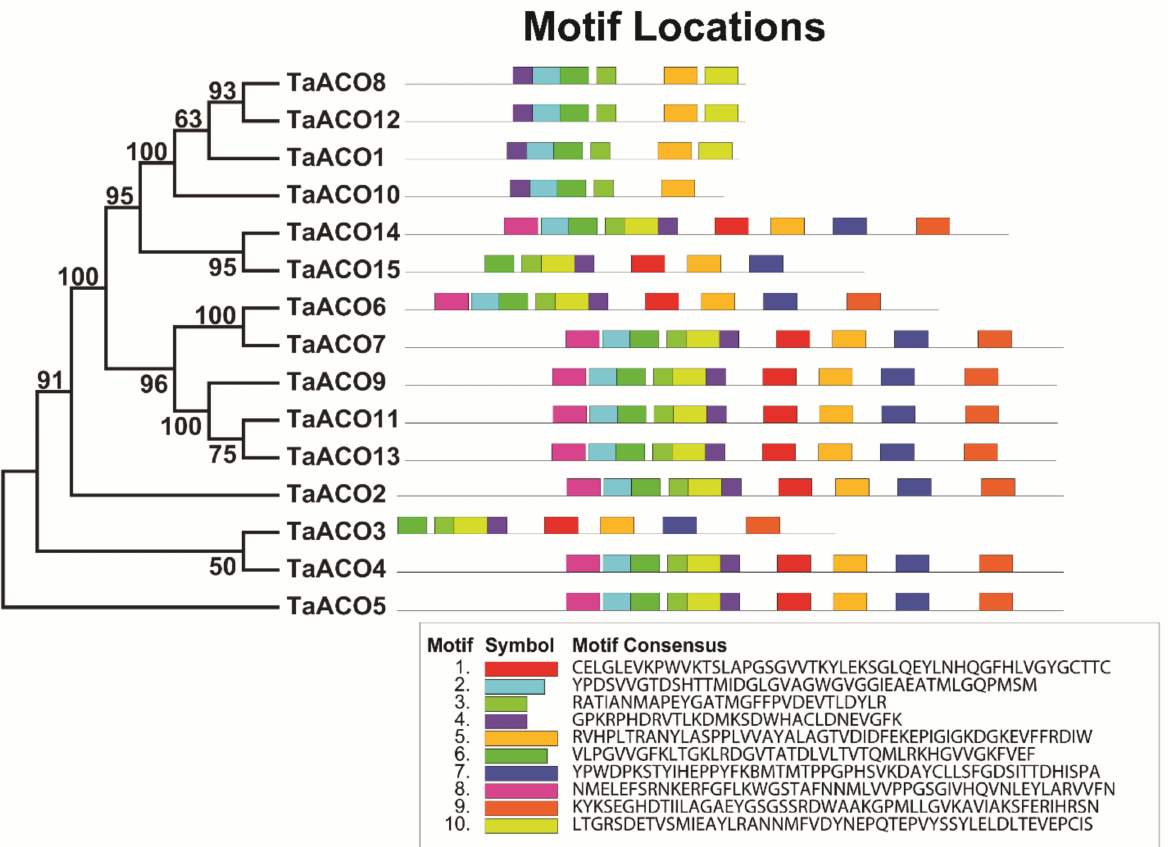
Figure 6. The motifs of TaACO genes are predicted by MEME. Distinct colored boxes denoting the various preserved motifs having differing sizes and